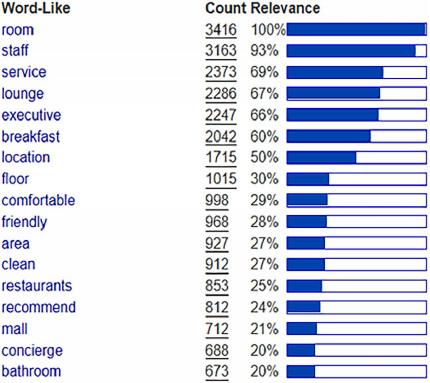
mapFigure Figure 3. The statistics of the partial themes Figure 4. Concepts and examples related to the “Location” Figure 5. Partial theme